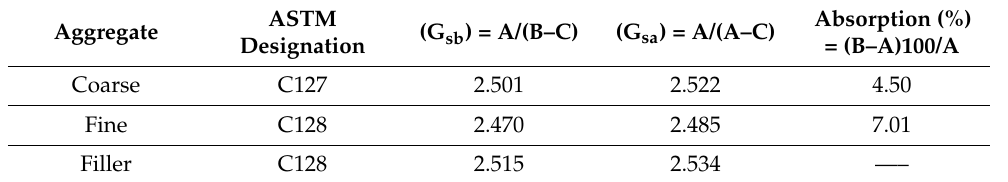
Table 2. Aggregate physical